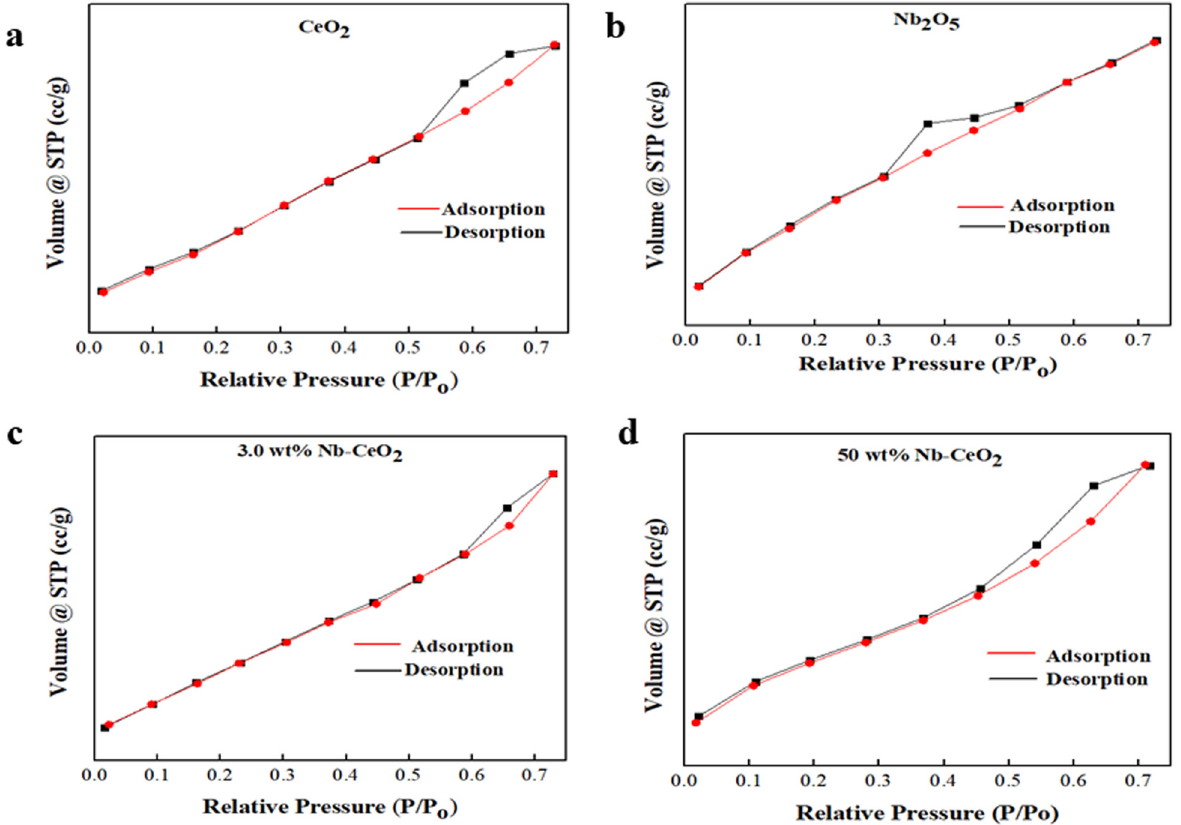
Figure 3: N 2 adsorption – desorption isotherms for the prepared samples. ( a ) CeO 2 ; ( b ) Nb 2 O 5 ; ( c ) 3 wt% doped, and ( d ) 50 wt% doped Nb - CeO 2